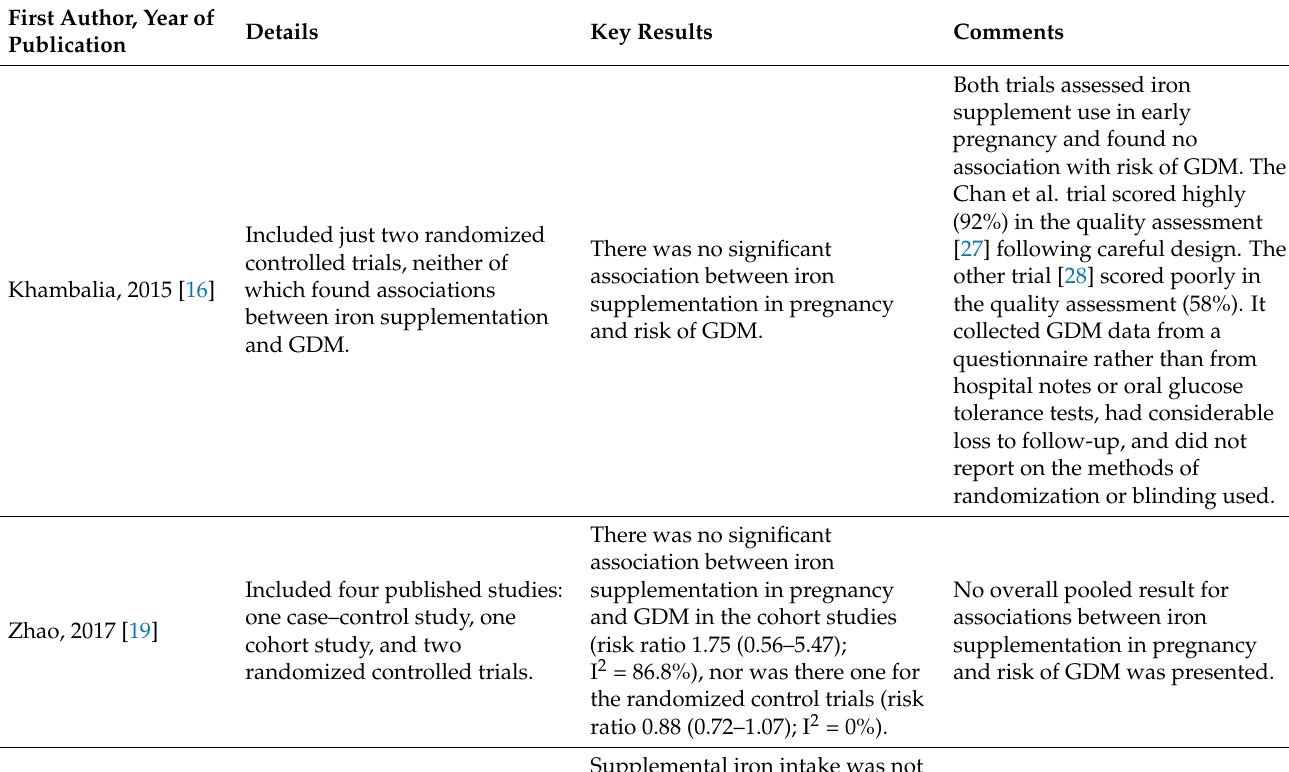
Table 5. Meta-analyses that sought associations between iron supplementation in pregnancy and